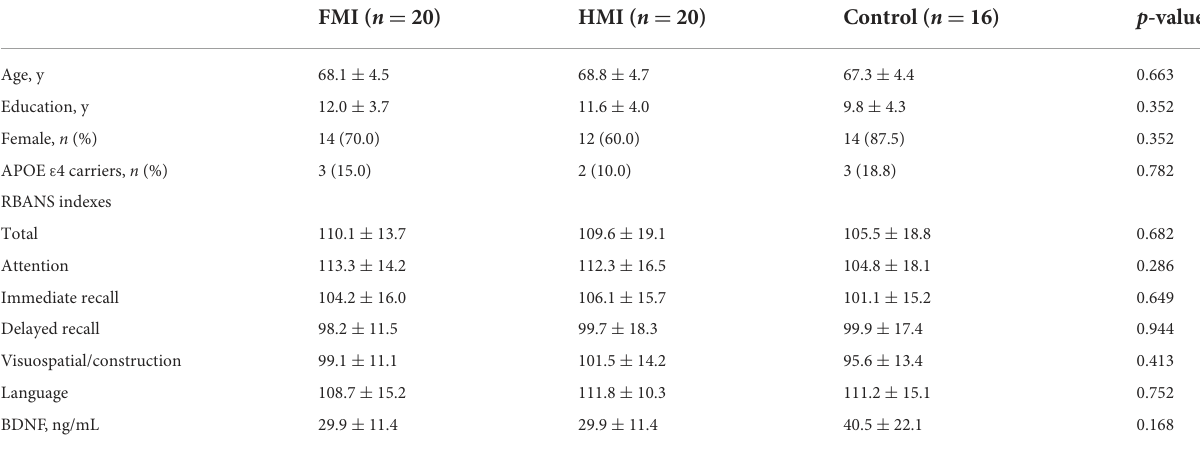
TABLE 1 Baseline clinical characteristics in the intervention and control